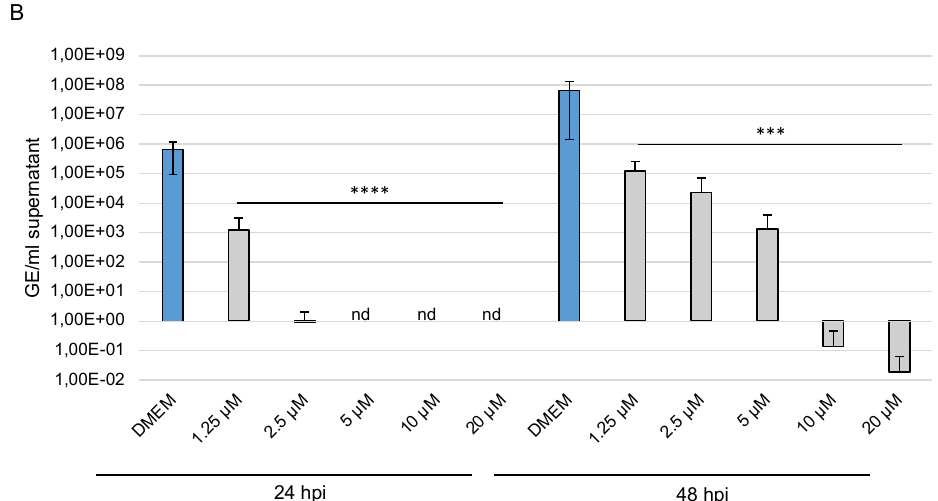
Figure 8. Effects of the high-sulfated GAGs on BCoV replication. PT cells were inoculated with a 2-fold dilution series of sHA3 ( A ) or sCS3 ( B ) prior to and after infection with BCoV (MOI 0.00005). At 24 and 48 hpi, the supernatants were harvested, and viral RNA was extracted. In the following, the real-time quantitative RT PCR concentration of nucleocapsid gene copy numbers was determined. Values shown represent three independent experiments. * p < 0.0332, *** p < 0.0002, **** p < 0.001; GE, genome equivalent.